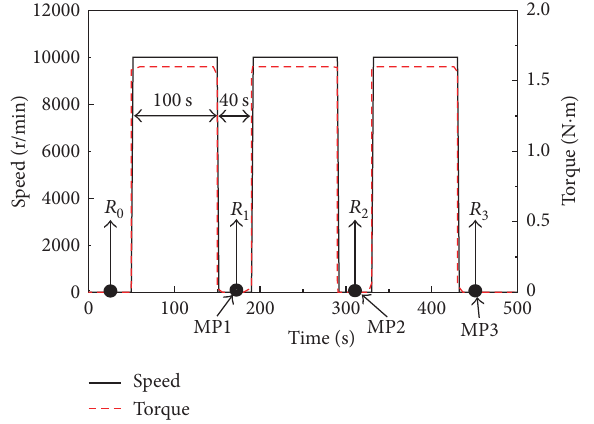
Figure 9: Process of the resistance measurement.